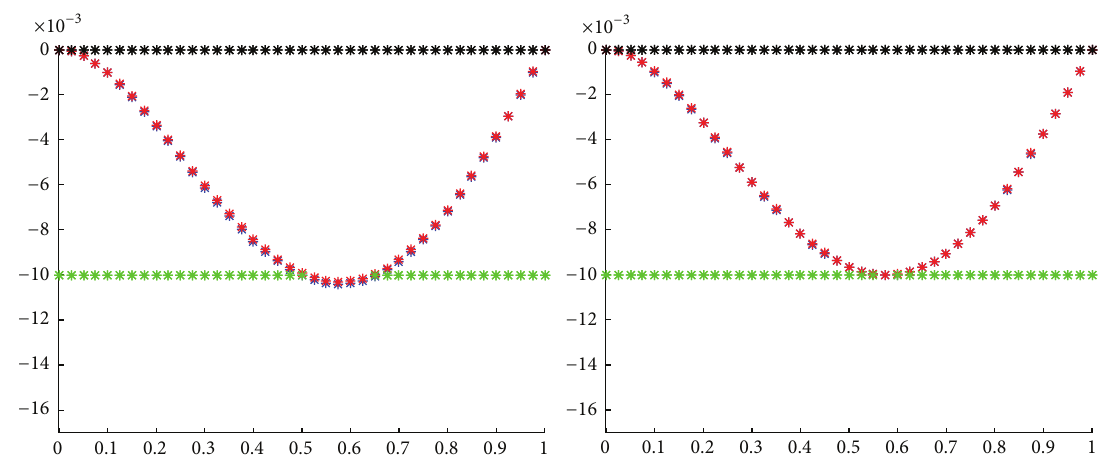
Figure 4: Results of Examples 3 and